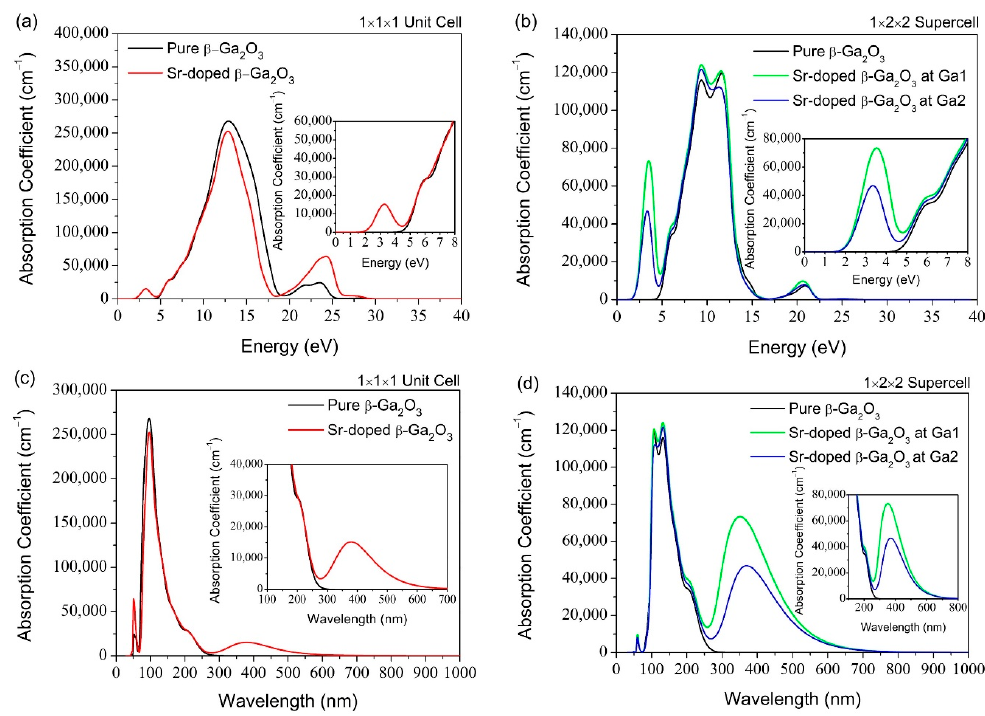
Figure 11. Absorption coefficient against ( a ) Energy (eV) for 1 × 1 × 1 pure and Sr-doped β -Ga 2 O 3 , ( b ) Energy (eV) for 1 × 2 × 2 supercell pure and Sr-doped β -Ga 2 O 3 , ( c ) Wavelength (nm) for 1 × 1 × 1 unit cell pure and Sr-doped β -Ga 2 O 3 , ( d ) Wavelength (nm) for 1 × 2 × 2 supercell for pure and Sr-doped β -Ga 2 O 3.